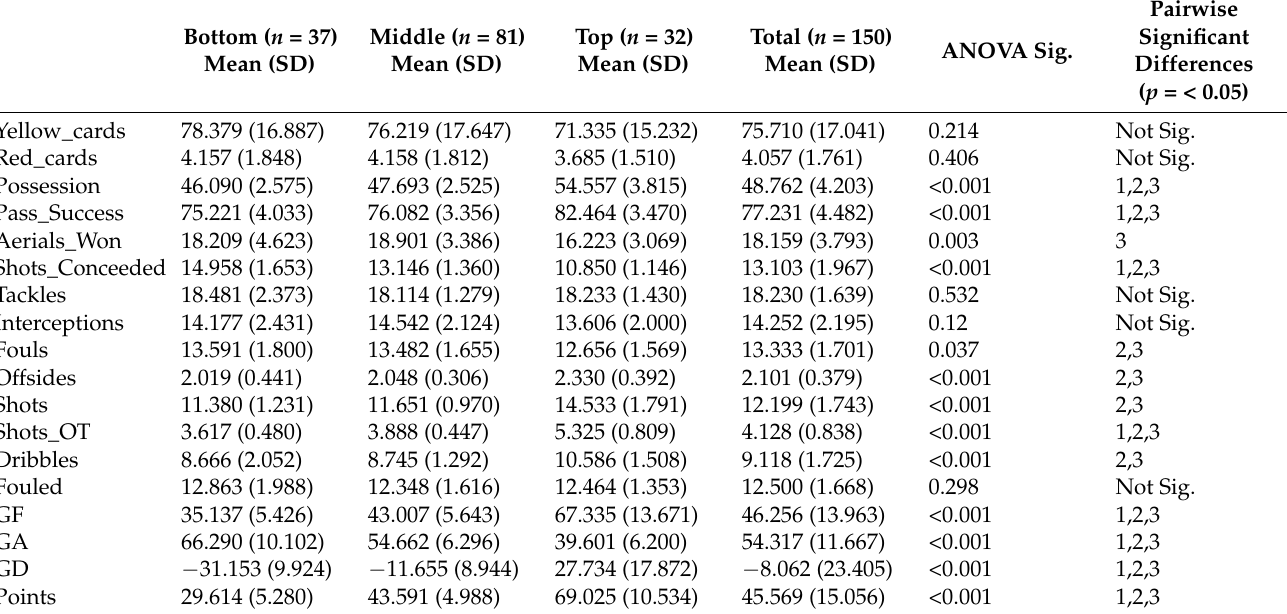
Table 2. Descriptive statistical results for aggregated data (all seasons) and one-way ANOVA